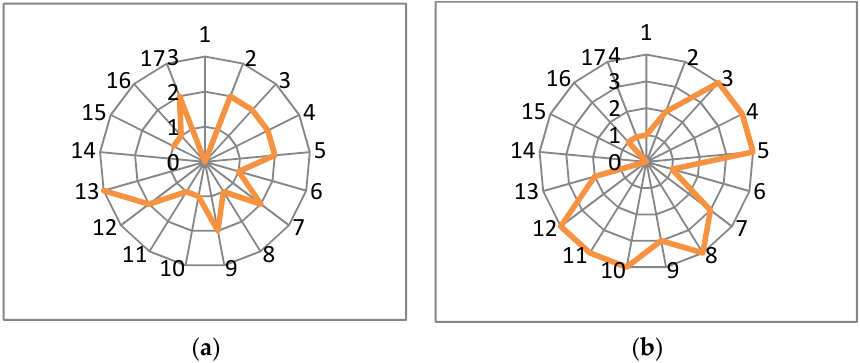
Figure 2. ( a ) Czech Republic’s level of achievement; ( b ) Czech Republic’s companies’ coverage of the Sustainable Development Goals (SDGs) (incident rate in COPs).